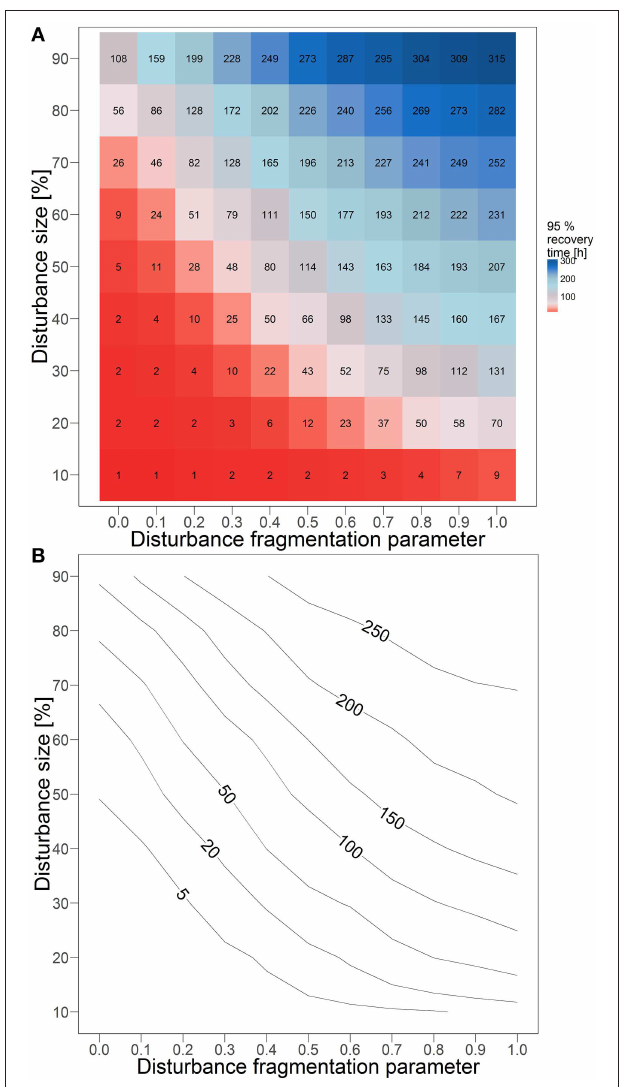
FIGURE 3 | Time (in hours) for recovering 95% of biodegradation performance after disturbance events of different sizes and fragmentations presented (A) with boxes show mean value of 130 independent runs and (B) corresponding contour lines.